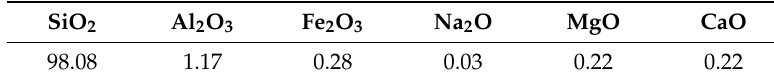
Table 2. Silica Sand (wt. %).